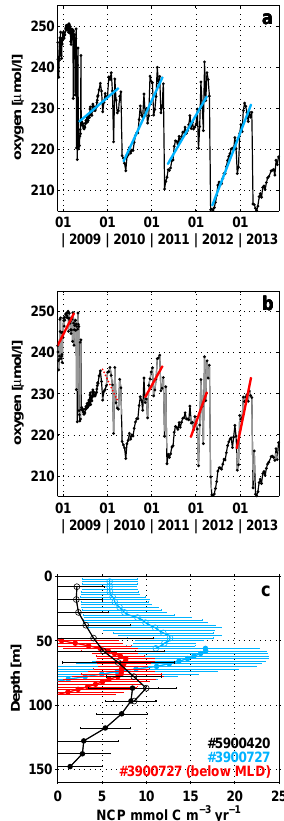
Figure 10. Oxygen concentration for float no. 3900727 at 58m depth (a) and 64m depth (b) shown as black lines and dots. Grey lines show the oxygen concentration below the mixed layer depth (b) . Blue (a) and red (b) lines (dots) are fitted to the oxygen in- crease (decrease) each year for the period mid-May to early April (a) and for a period depending on the depth of the mixed layer (b) . Net community production (NCP; in mmolCm − 3 yr − 1 ; b ) for float WMO no. 5900420 (at 20 to 22 ◦ S, 119 to 128 ◦ W; as used in Riser and Johnson, 2008) with oxygen slope against time computed for the period mid-June to early May (black circles and dots) and for float 3900727 (see Fig. 8) with oxygen slope against time for the period mid-May to early April (blue circles and dots) both extrap- olated for 365 days. NCP calculated only below the mixed layer depth for float 3900727 with variable periods (red dots). Open sym- bols were calculated from the slope of oxygen anomaly (oxygen– oxygen solubility) against time in the mixed layer. Solid symbols are an extrapolation to the surface of the highest rates based on the slope of oxygen against time at each site. Oxygen production was converted to carbon units using the modified Redfield ratio as in Riser and Johnson (2008). Error bars show the standard deviation of the